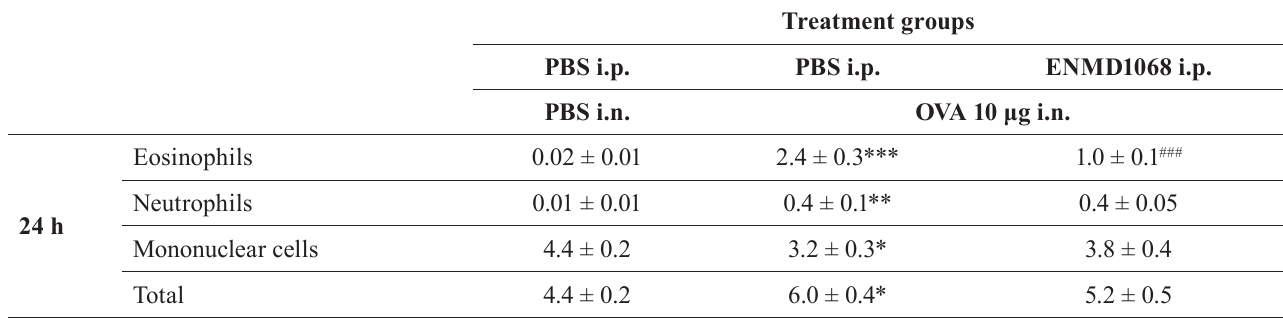
TABLE I - T otal and differential cell counts (x 10 5 cells) in BALF 4h or 24 h after i.n. instillation of OVA in PAR-2 antagonist ENMD1068-treated sensitized mice